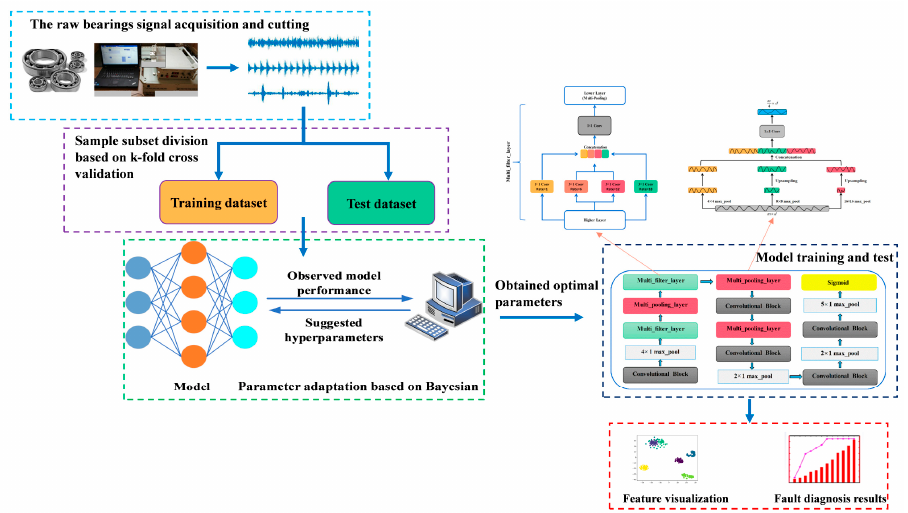
Figure 3. The process of Bayesian optimization.